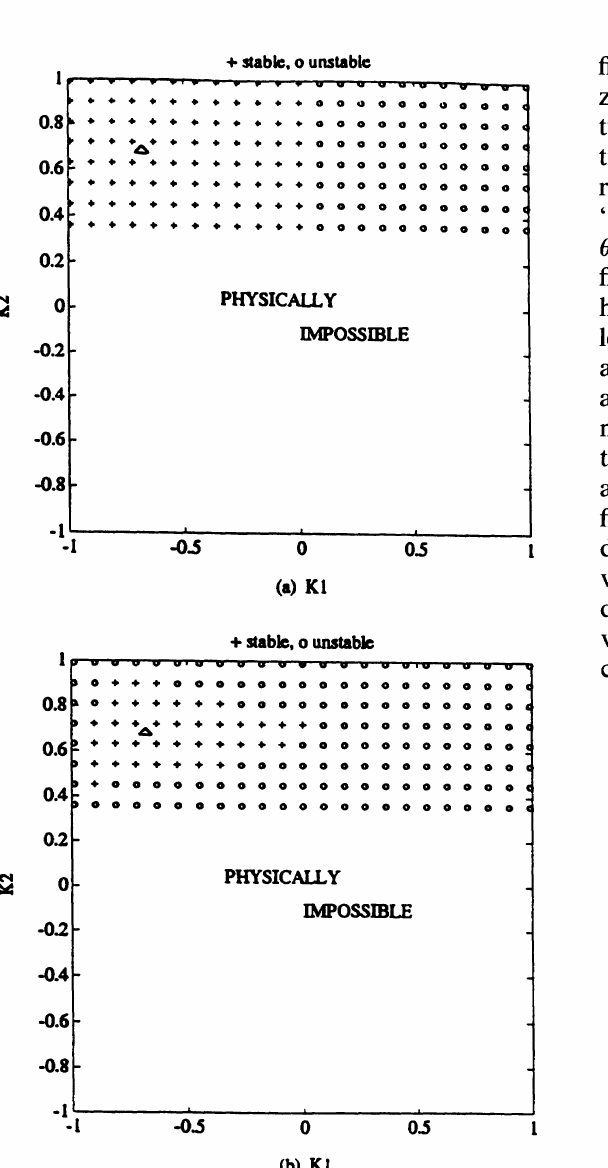
FIGURE 10 Stability diagrams for Example 3, (a) 6, = 6 2 = 0°, (b) 6, = 12.3°, 6 2 = 12.0°.